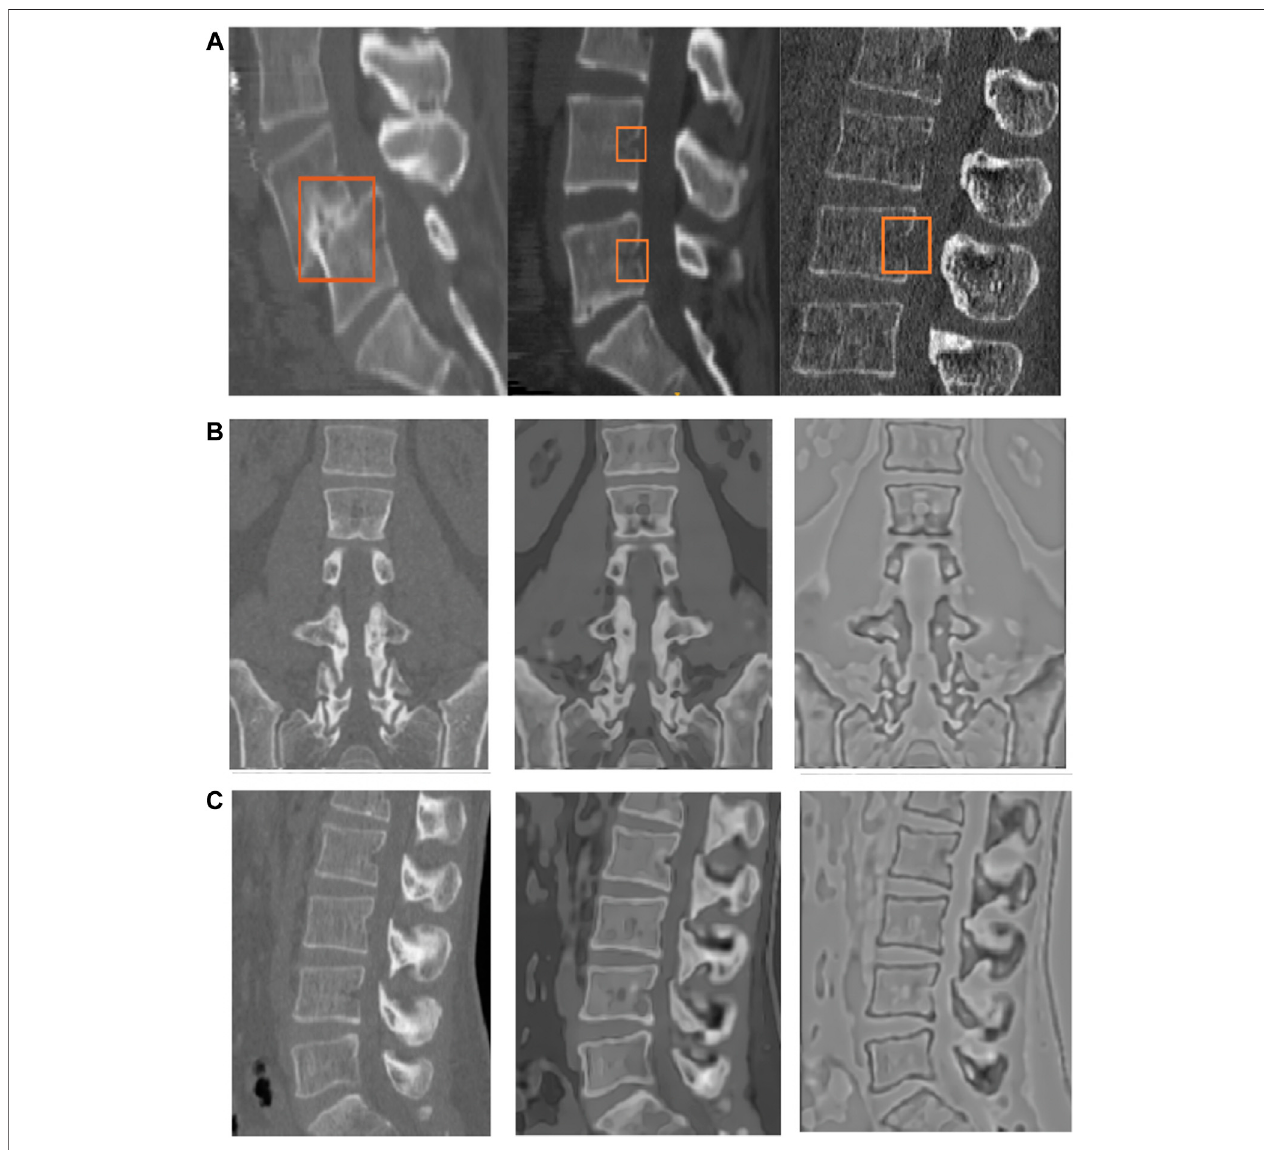
FIGURE 1 | (A) Examples of challenges in spine segmentation. The image on the extreme left shows an anterior-posterior subluxation of the L4 and L5 vertebrae. The image in the middle shows gaps on the vertebral boundary, which may be physiological due to vessel injection at this location. The image on the right has missing boundariesaswell,and adifferentintensity distribution duetothe useofadifferentscannerand acquisitionprotocol. (B and C) Coronaland sagittalslices oftheoriginal image (left column), edge-enhanced image (middle column) and fl ux-map (rightmost column). The application of the edge-enhancing diffusion process, as explained in Section 2.2.1 , on the original image (left column) results in the edge-enhanced image (middle column). The contrast between the vertebral cortical bone surface and its nearby regions (rightmost image) is enhanced due to the fl ux computation step, as explained in Section 2.2.2 .